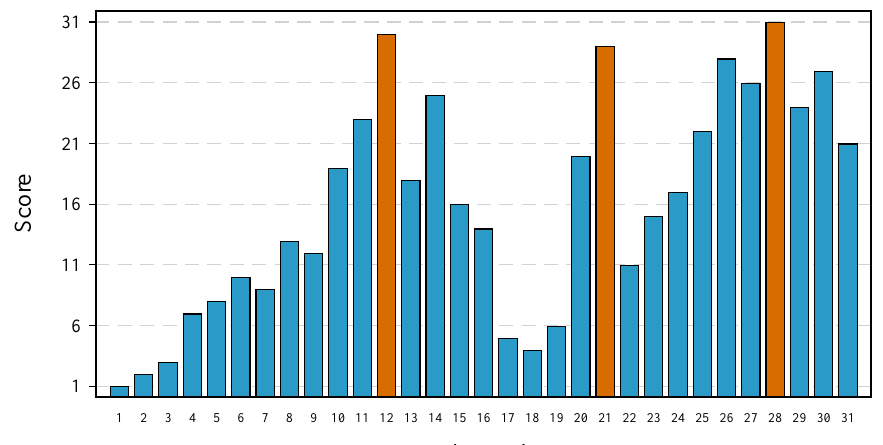
Figure 2. Computed three-sensor placement in the Hanoi network.